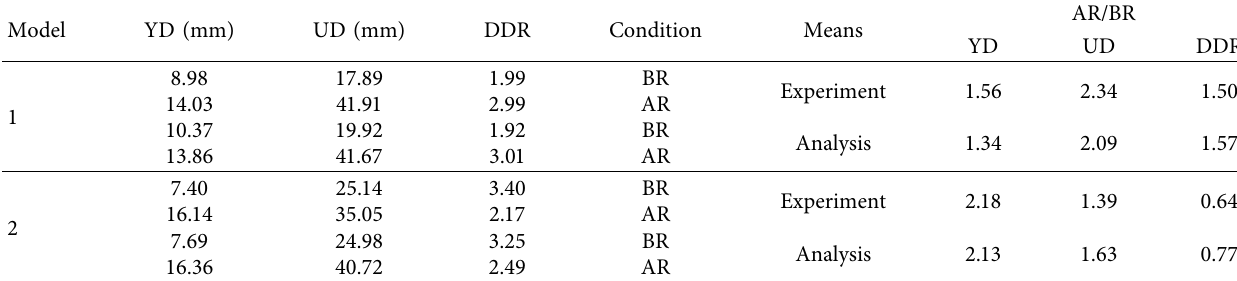
Table 6: Displacement ductility of